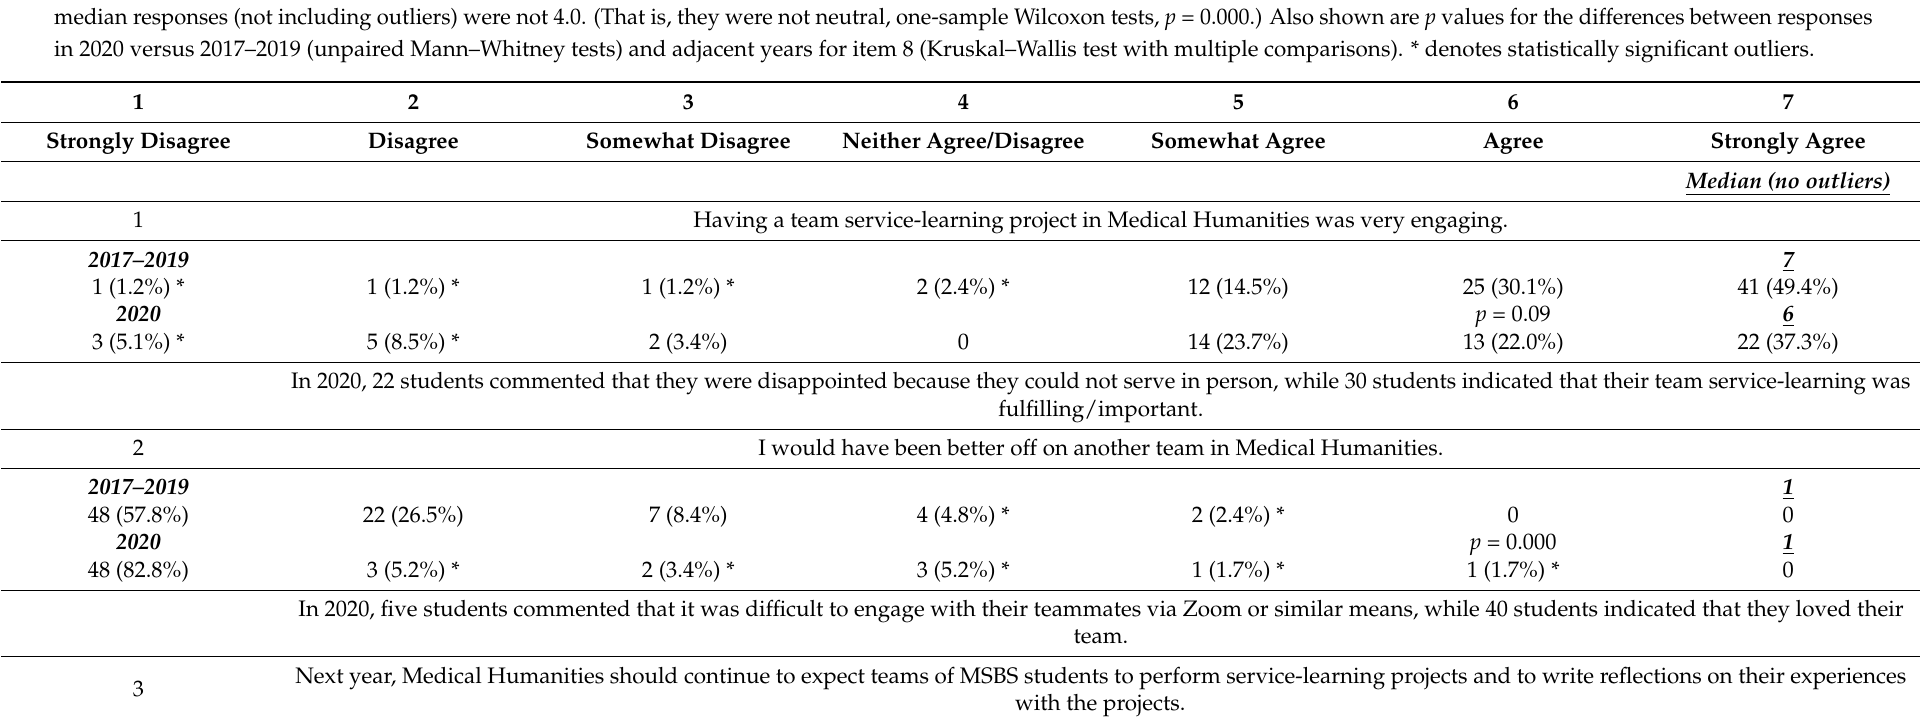
Table 1. Team- and service-learning survey responses by Medical Humanities students in 2020 versus the previous three years (2017–2019). Except for item 8 in 2017, 2018, and 2020, median responses (not including outliers) were not 4.0. (That is, they were not neutral, one-sample Wilcoxon tests, p = 0.000.) Also shown are p values for the differences between